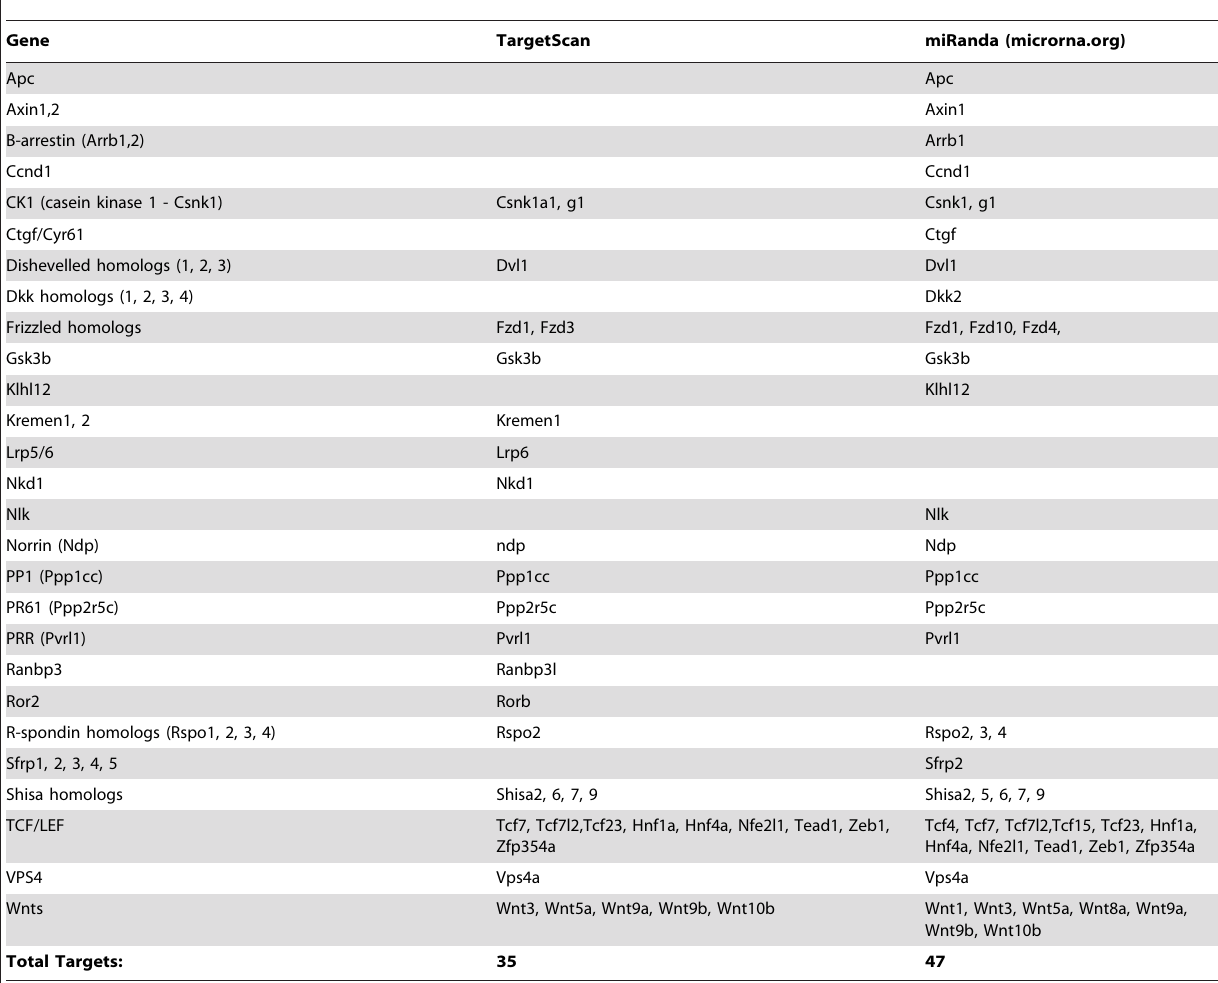
Table 1. Predicted miR135a targets in the Wnt signaling